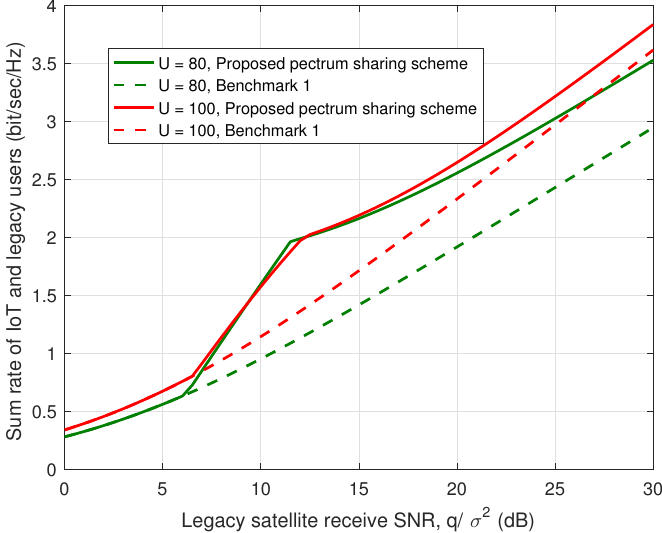
Figure 5. Sum rate of IoT and legacy satellite users vs. legacy satellite receive